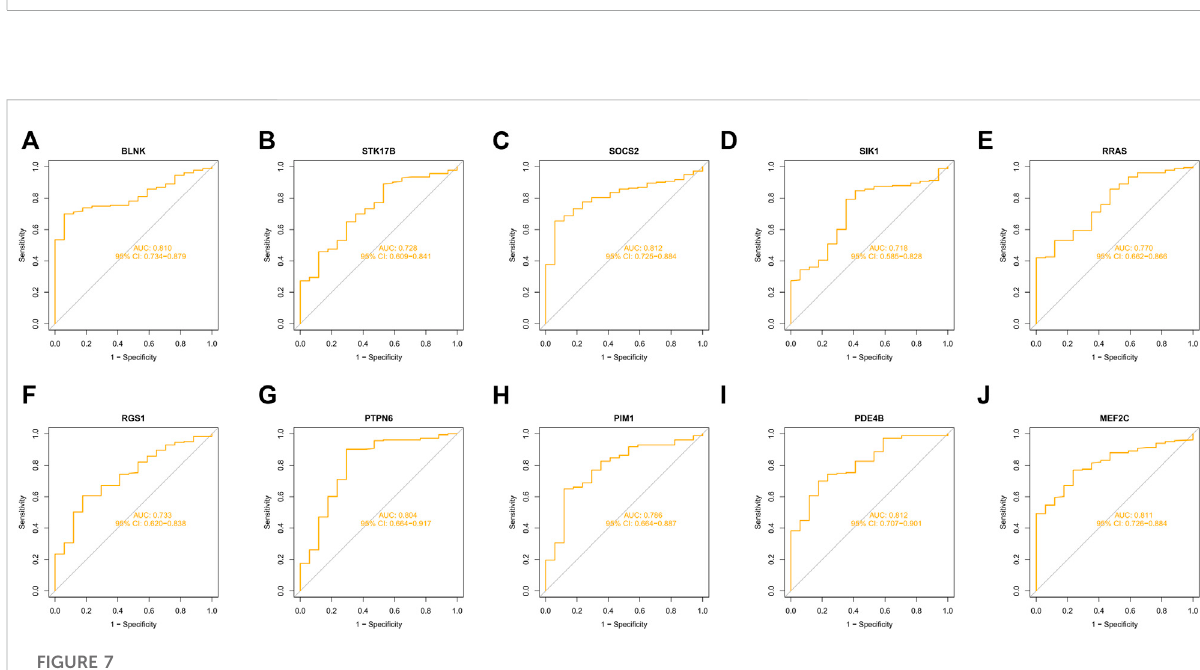
FIGURE 7 ROC curves of key genes for MDS diagnostics (A) BLNK; (B) STK17B; (C) SOCS2; (D) SIK1; (E) RRAS; (F) RGS1; (G) PTPN6; (H) PIM1; (I) PDE4B; (J)